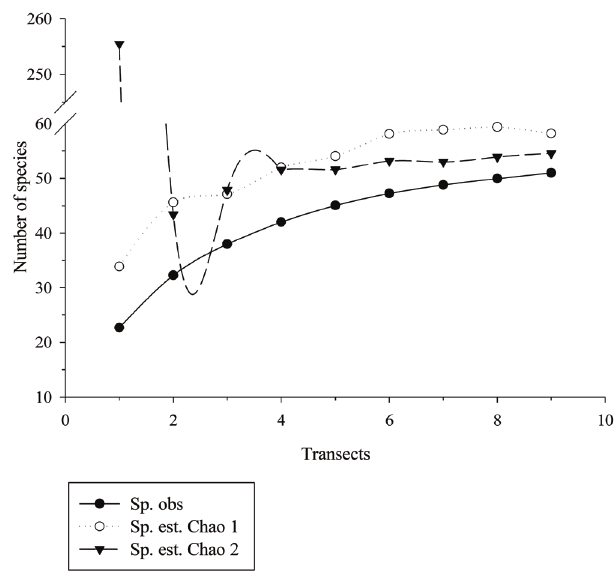
Fig 2. Plant species accumulation according to Chao1 and Chao2 estimators and observed accumulation of species of plants in the Cerrado of the Estação Ecológica de Pirapitinga - Minas Gerais (see text for details). Axis Y (species number) was interrupted in interval 60 - 245 for better visualization of the